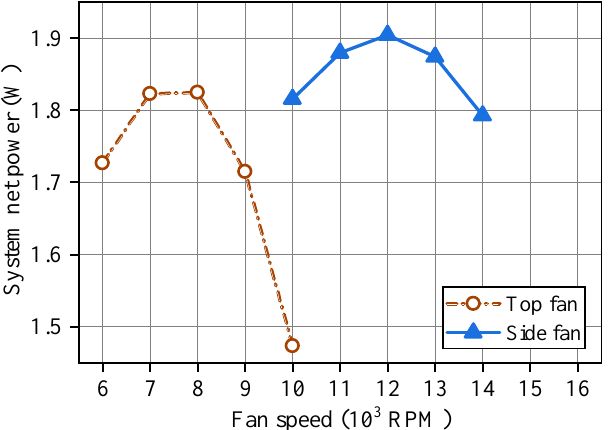
Figure 11. System net power comparison between the TMF system with three TEGs and three fans and the SMF systems with three TEGs and a single